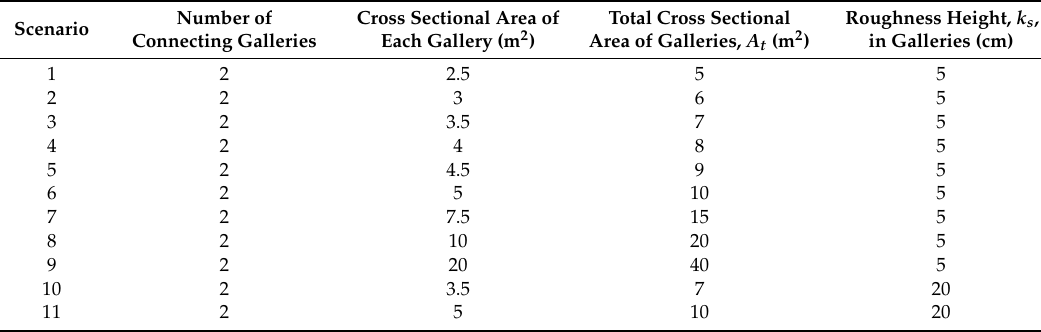
Table 2. Examined scenarios in numerical